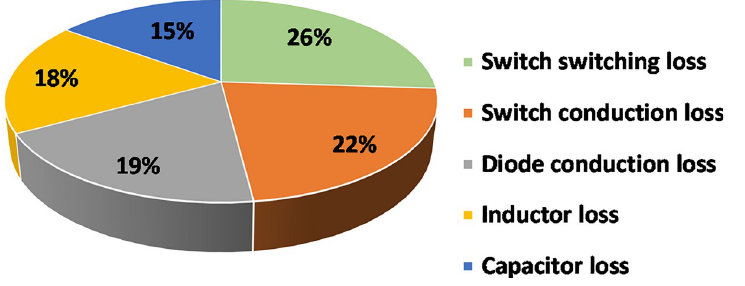
Fig 14. Loss breakdown (calculated value) of the key components of the developed converter.